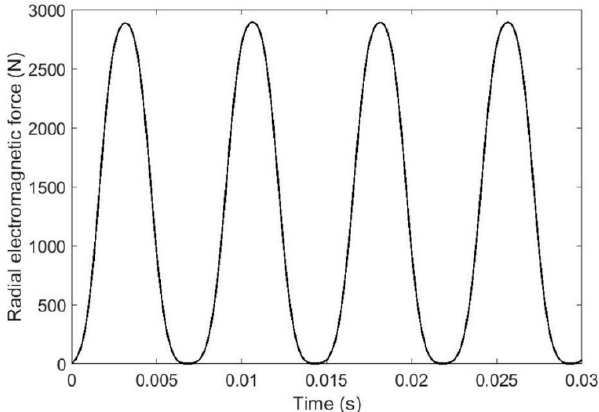
Figure 3. Output torque of the BLDC motor. The radial EM force acting on the stator tooth was calculated as shown in Figure 4. Vibration analysis was performed by inputting the calculated radial EM force into the stator structure.